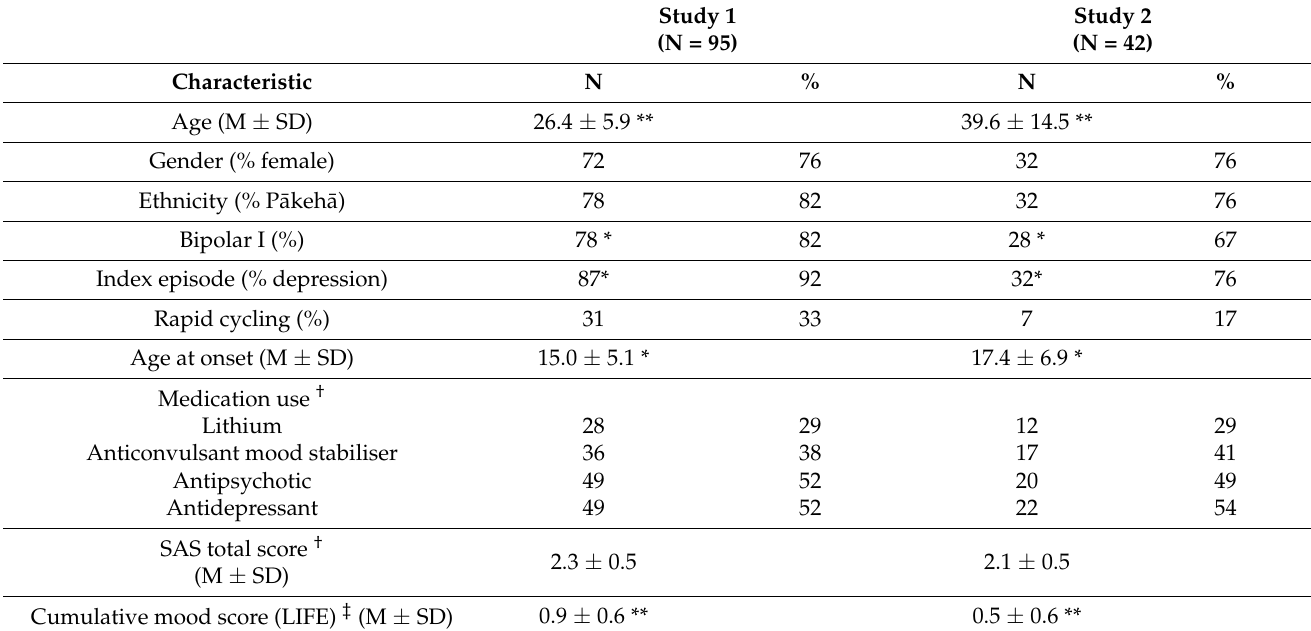
Table 1. Clinical Characteristics of Study